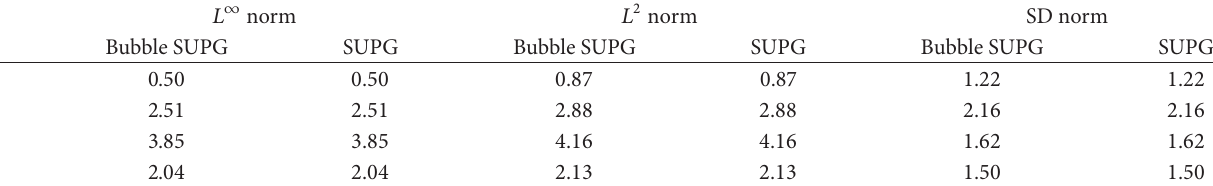
Table 14: 𝜀 = 10 −8 , Problem 4 (comparison of convergence rate).